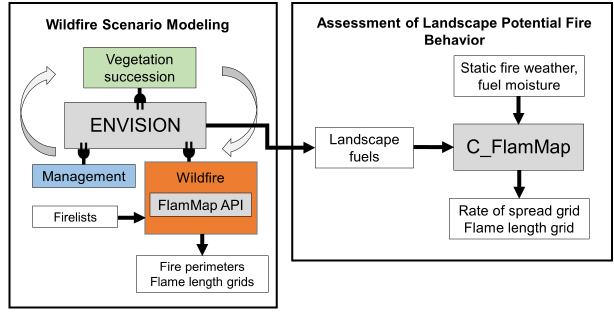
Fig. 2 . Overview flow chart of wildfire scenario modeling showing the major “plugins” or submodels coupled to the Envision modeling framework. Wildfire events are simulated annually (left) using the FlamMap Application Programming Interface (API) as described in the text. Landscape potential fire behavior (flame length, spread rate) is calculated (right) using annual Envision outputs on landscape conditions that are processed through a command line version of FlamMap (C_FlamMap) as described in the